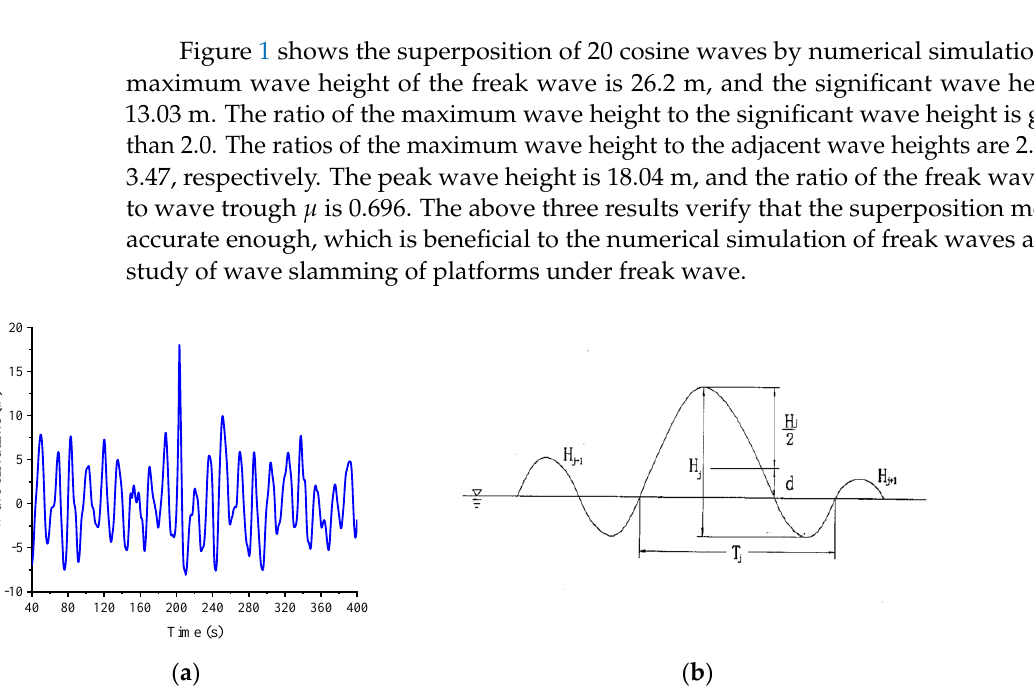
Figure 1. A superposition of 20 cosine waves. ( a ) Time history of wave elevations by numerical simulation. ( b ) Freak wave profile.